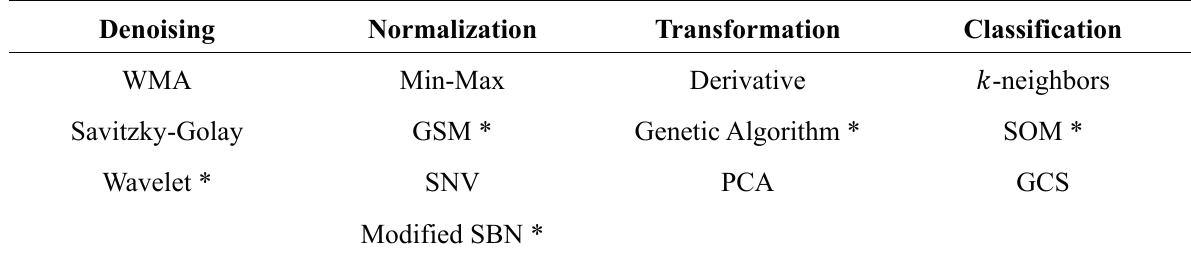
Table 1. Algorithms of the four-step signal-processing